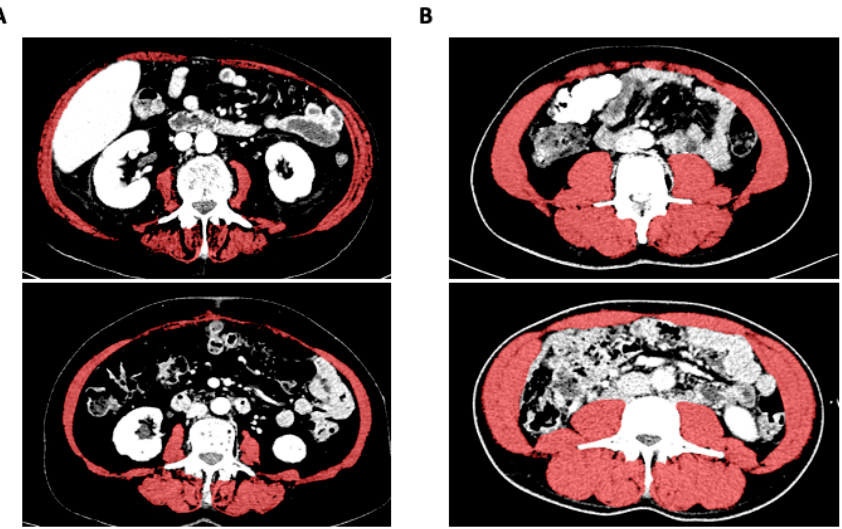
Figure 1. Evaluation of the L3SMI using the 3D slicer tool. Exemplary presentation of CT scans from patients with low ( A ) or high ( B ) L3SMI value.